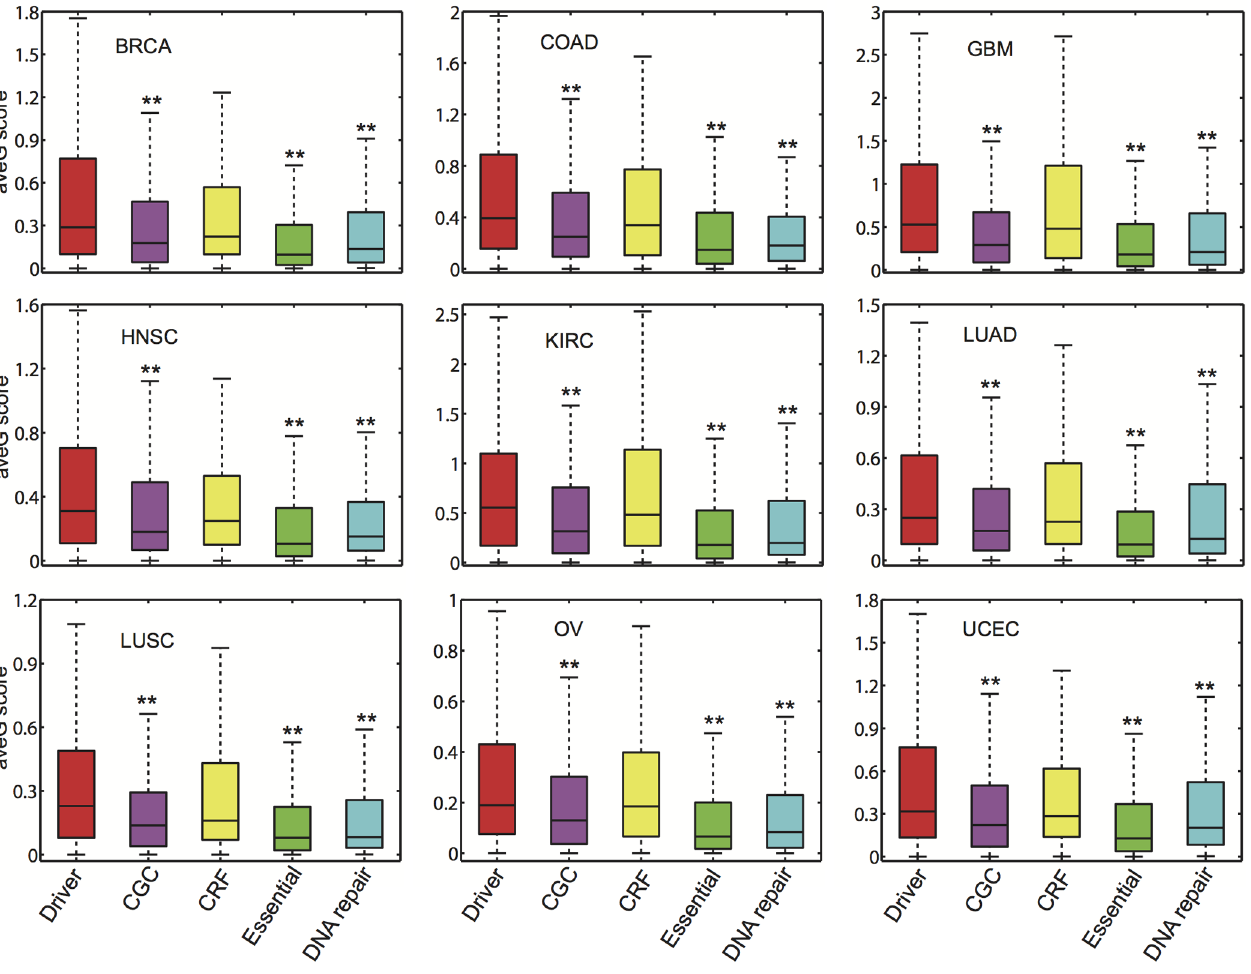
Fig 2. Box plots of gene average gravitation (ave G ) score for five gene sets across 9 cancer types. Red: cancer driver genes (Driver); purple: Cancer Gene Census (CGC) genes; yellow: chromatin regulation factors (CRF); green: essential genes (Essential); and blue: DNA repair genes. The adjusted p- values ( q ) are based on the comparison of the gene average gravitation score of cancer driver genes with CGC, CRFs, essential genes, and DNA repair genes respectively, by Wilcoxon rank-sum test corrected by Benjamini-Hochberg multiple testing. ** : q < 0.01. The detailed data are provided in S4 Table. Abbreviations of 9 cancer types in Figs 2 – 5 are provided in Fig 1